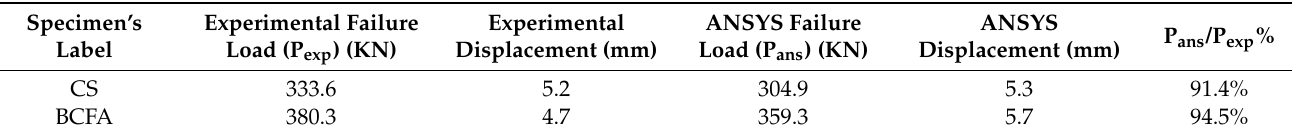
Table 4. Failure Loads and Corresponding Displacements for the Verification Models.